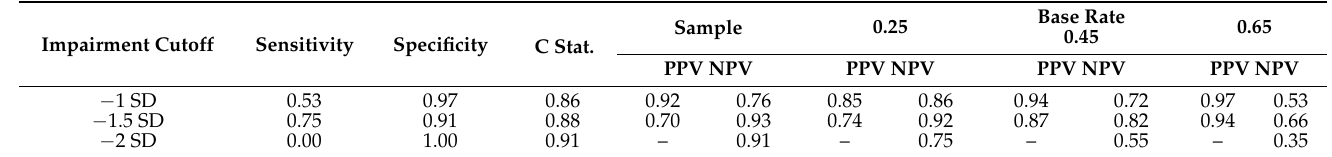
Table 5. Binary logistic regression models’ sensitivity, specificity, and positive and negative predictive values based on different PD-MCI prevalence